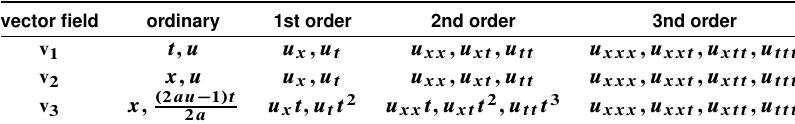
Table 9. Differential invariants for BBM equation vector field